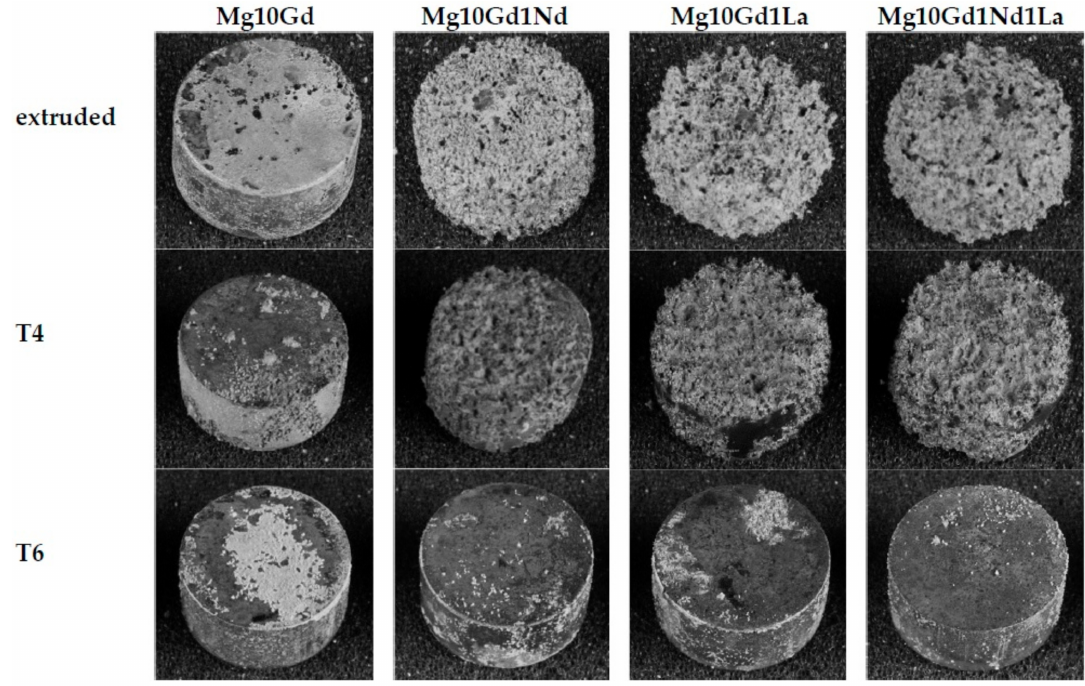
Figure 10. Optical morphology of samples corroded by immersion: the top row shows the extruded condition, the middle row shows T4, and the bottom row shows T6 (initial diameter 10